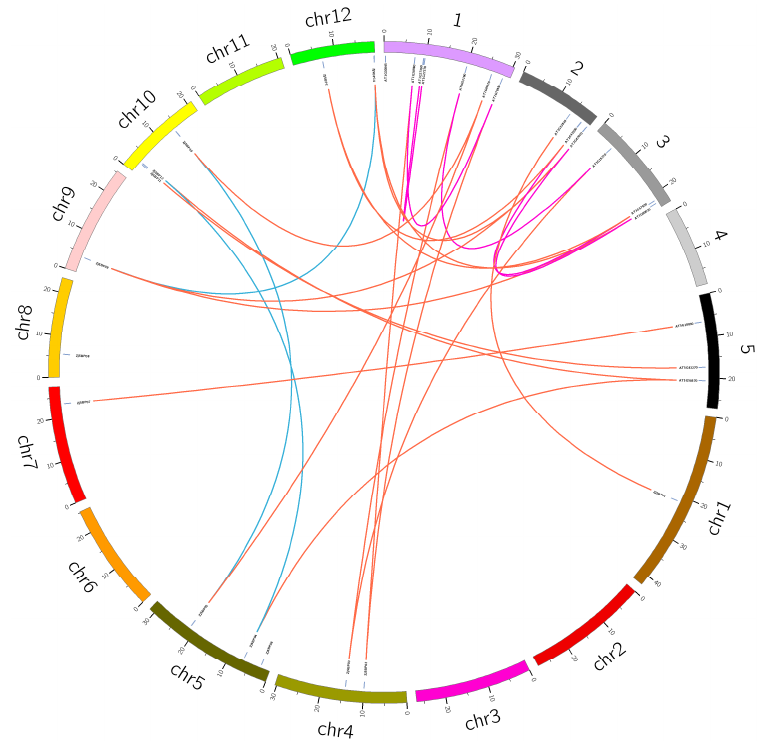
Figure 6. The homologous gene pairs between Z. jujuba Mill. Dongzao and Arabidopsis with Circus. Red, purple and blue lines indicate homologous gene pairs between Z. jujuba Mill. Dongzao and Arabidopsis , and Arabidopsis and Z. jujuba Mill. Dongzao.